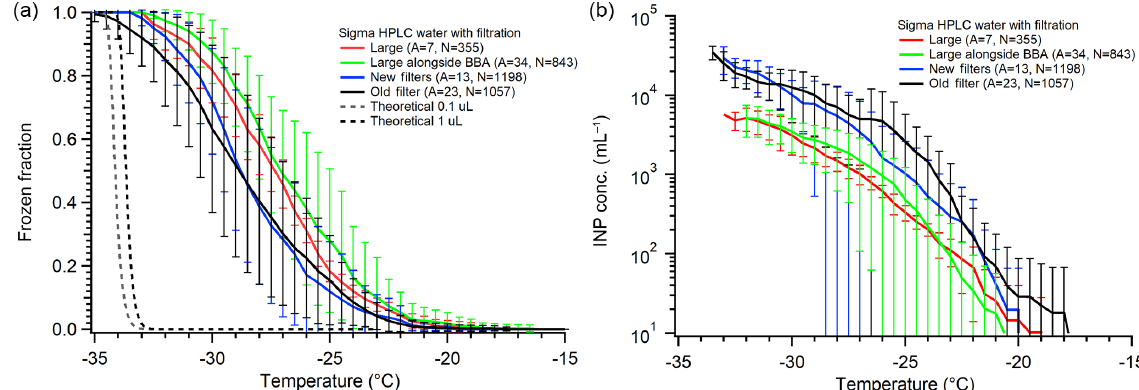
Figure 5. Droplet freezing temperature spectra (a) and apparent ice nuclei concentration, c IN , (b) for pure water droplet freezing measure- ments on a hydrophobic cover slip. In all experiments HPLC water that was filtered using an Anotop 0.02µm syringe filter was used. Each data series has been binned into 0.5 ◦ C temperature increments. The red data series is from large (1.0µL) droplets, green is from large (1.0µL) droplets measured alongside biomass burning aerosol sample droplets (Fig. 12), blue is from small (0.1µL) droplets using a new Anotop filter for each stock bottle of filtered water, and black is small droplets using a singular Anotop filter for many different stock bottles of water. The parentheses next to each legend entry contains the number of arrays of droplets ( A ) and the total number of droplets across all arrays ( N ) tested for each experiment type. Error bars are standard deviations for the replicate droplet arrays. The gray and black dashed lines indicate the theoretical homogeneous freezing curves of 0.1 and 1µL droplets, respectively, using the parameterization of Koop and Murray (2016).